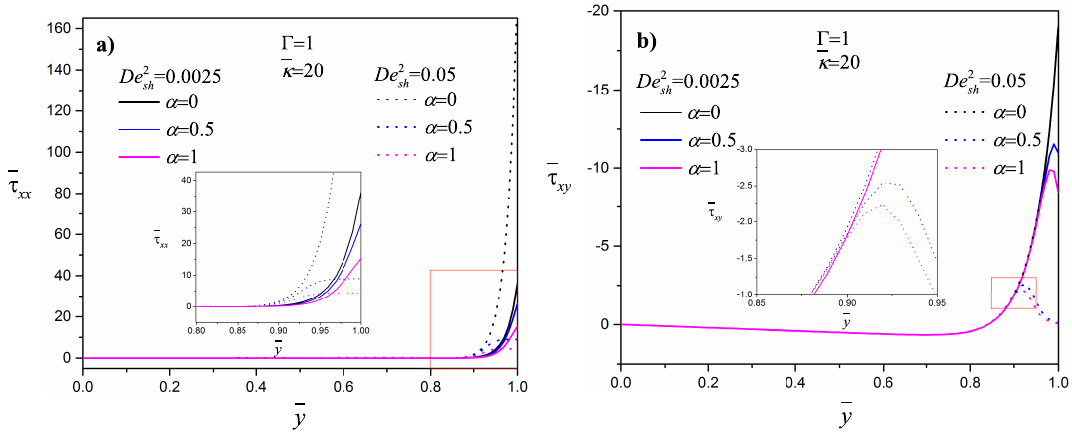
Figure 8. Dimensionless ( a ) normal and ( b ) shear stresses as a function of the position for the codeformational ( α = 0 ) , mixture ( α = 0.5 ) and corotational ( α = 1 ) models, for De 2 and 0.05.